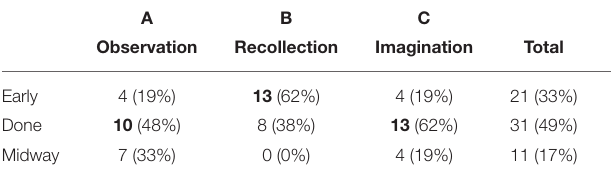
TABLE 5 | Completion status for each